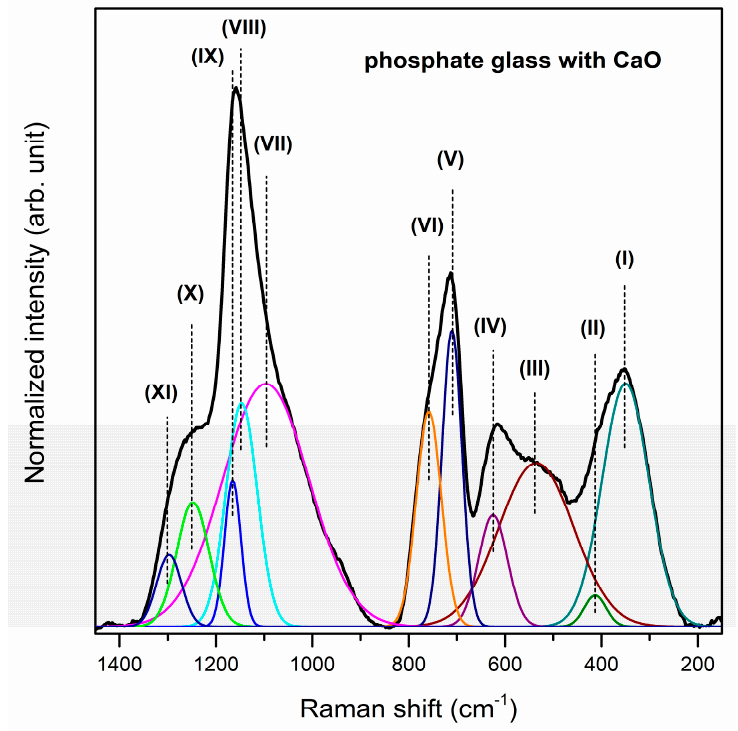
Figure 4. Deconvoluted Raman spectra of phosphate glass with CaO as oxide glass modifier.